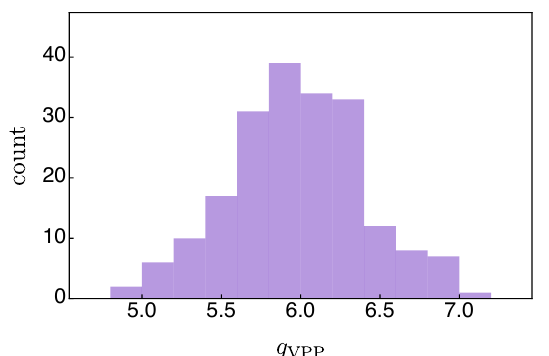
Figure 23. Histogram of derived quantity g VPP | see eq. (6.9) in section 6.1 | based upon the distributions in (cid:12)gures 21 and 22.